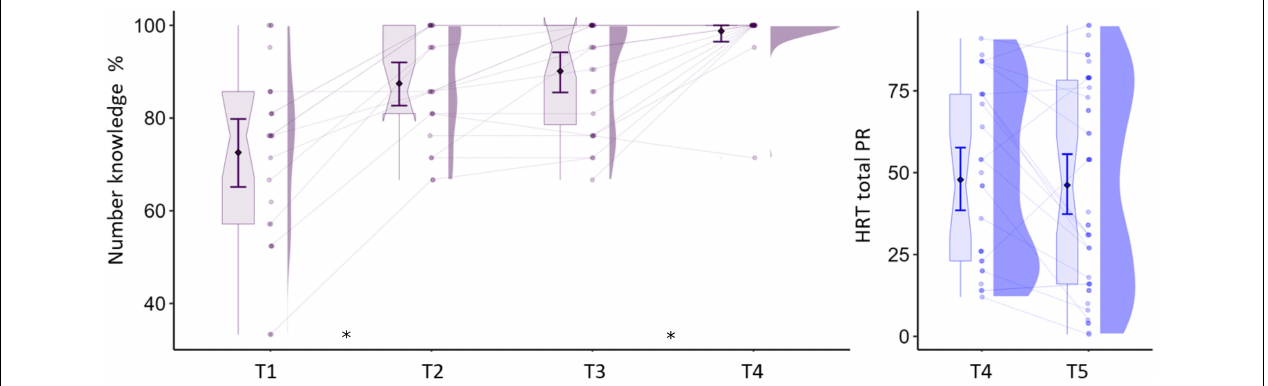
FIGURE 1 | Numerical skills across measurements. Y -axis in left panel shows the percentage of correctly named numbers and in the right panel, the total percentile score for arithmetic operations. Asterisks indicate significant differences at p < 0.05 between test times. Boxplots show median and interquartile range. Error bars indicate mean and 95%